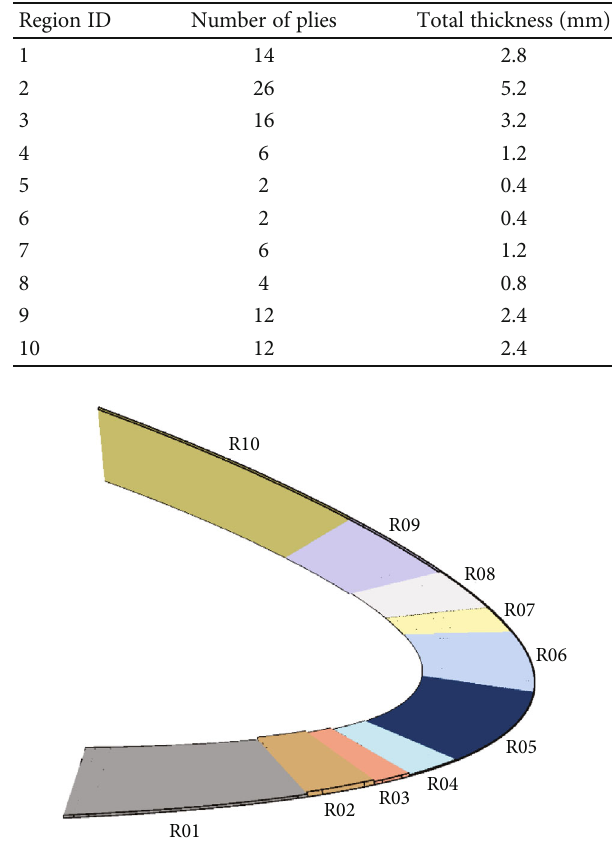
Table 2: Aluminium alloy mechanical